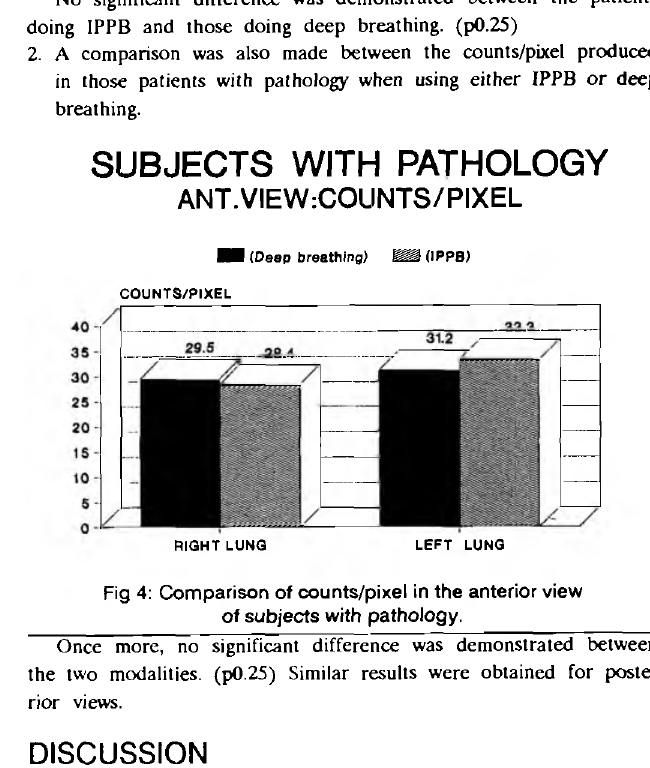
Fig 3: Comparison of counts/pixel in the anterior view of normal subjects.